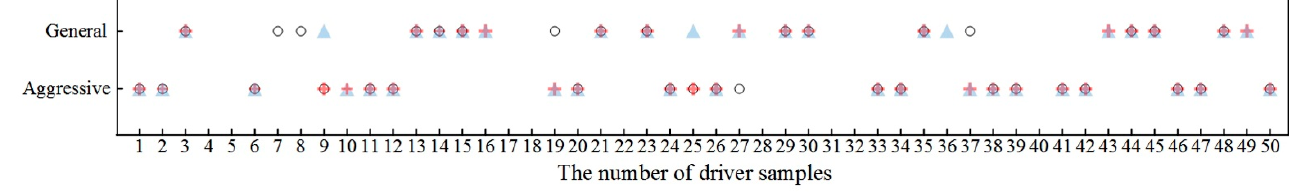
Figure 10. The experimental verification results based on 50 driver